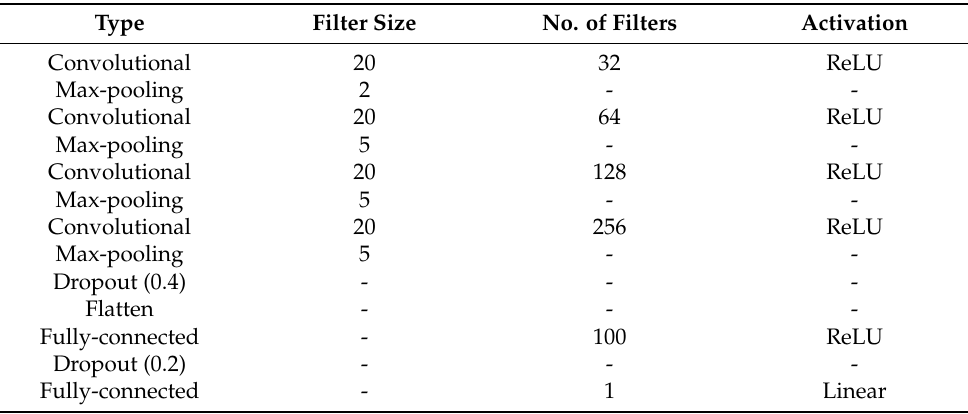
Table 1. Architecture of one-dimensional convolutional neural network